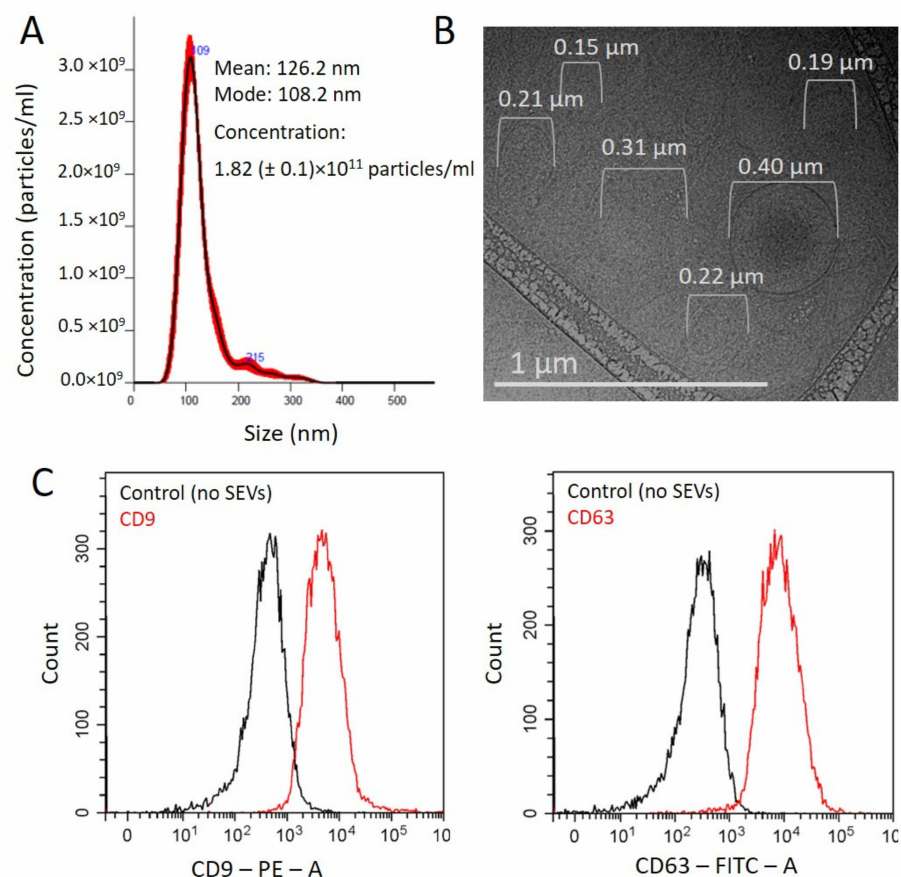
Figure 1. Characteristics of the total SEV population. ( A ) A representative example of NTA vesicles isolated by a two-phase polymer system. ( B ) Cryo-electron microscopy image of extracellular vesicles. ( C ) Detection of exosomal markers by flow cytometry. EVs attached to latex beads were stained with PC5.5-labelled antibodies to CD9 or FITC-labelled antibodies to CD63. Beads stained with antibodies were assayed as a negative